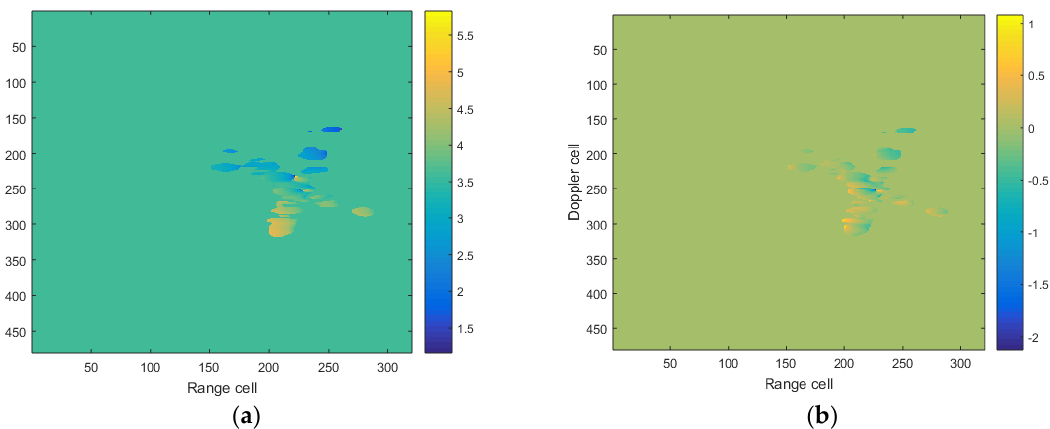
Figure 16. InPha images of real InPhas: ( a ) from X - direction interferometry, the InPha is continuous as indicated by the gradual change of colors between yellow and light blue; ( b ) from Z - direction interferometry, the InPha is continuous as indicated by the gradual change of colors between yellow and light blue.